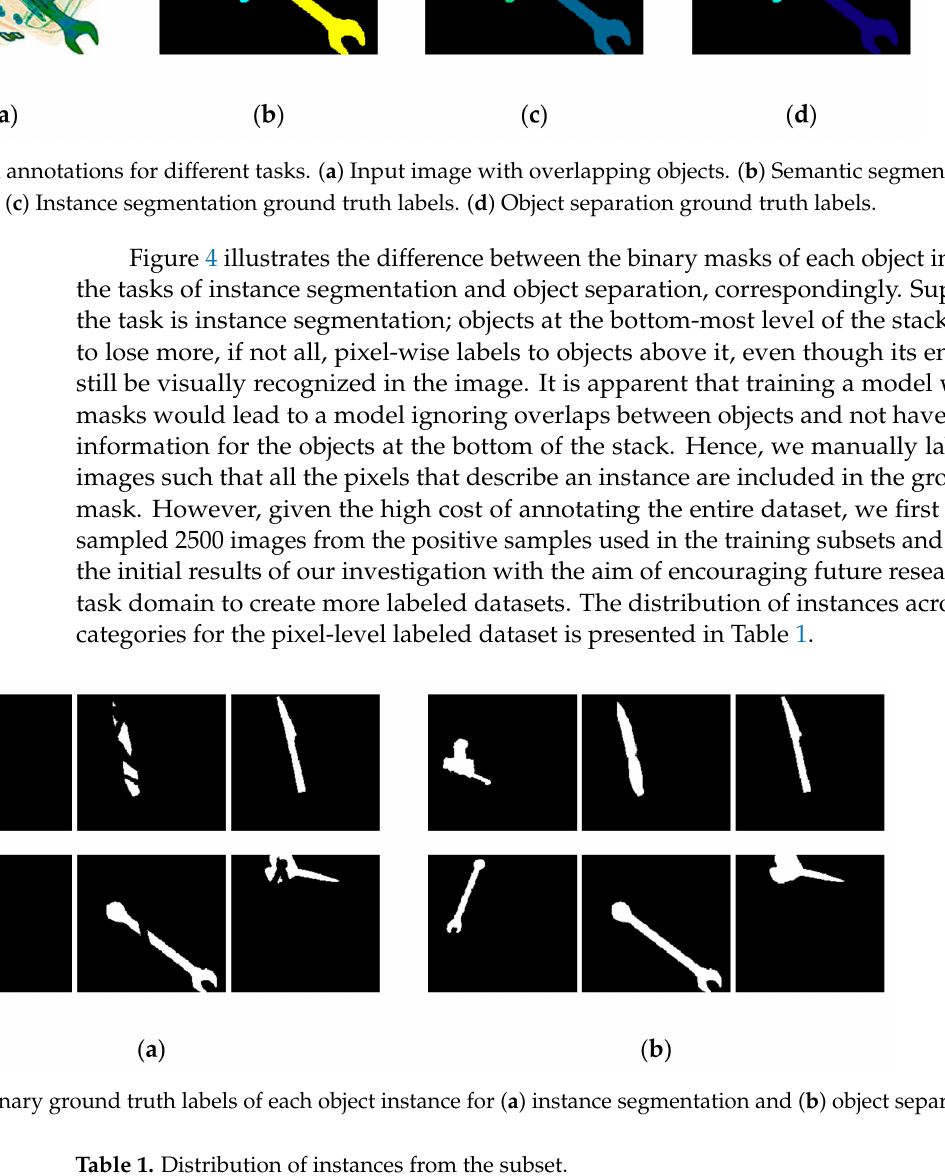
Table 1. Distribution of instances from the subset. Total Gun Knife Wrench Pliers